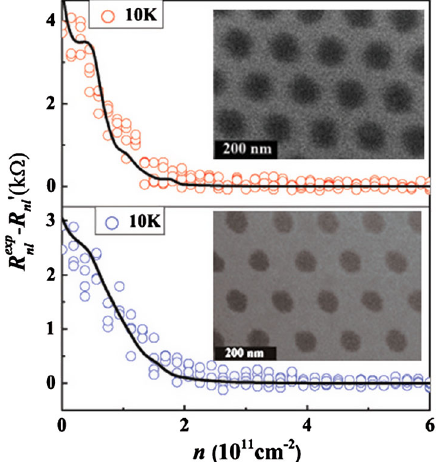
FIG. 14. The topological nonlocal resistance (defined as − R 0 R exp ) is plotted as a function of carrier density for sample nl nl B (upper panel), with a designed hole diameter of 80 nm, and sample C (bottom panel), with a designed hole diameter of 60 nm, shown by open circles for different samples with different geometric factors. The periodicity is fixed at 150 nm. The solid curves represent the fitted nonlocal